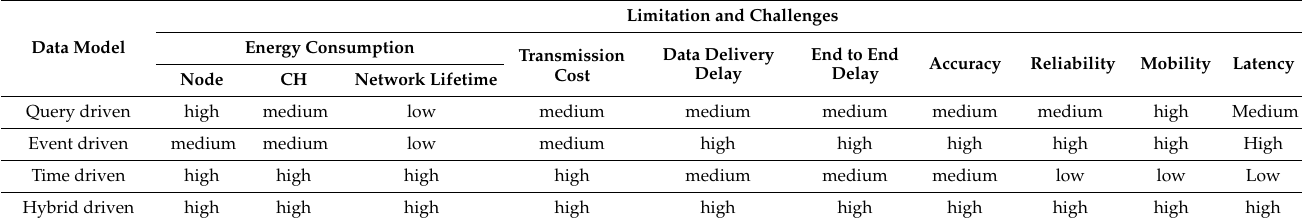
Table 3. Analyzes the limitation and challenges of each data-driven model in